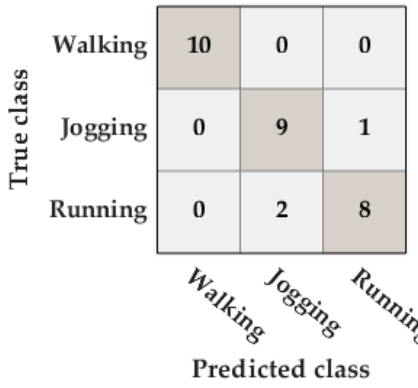
Figure 9. Confusion matrix of the classification of the type of activity in the Unicauca dataset.